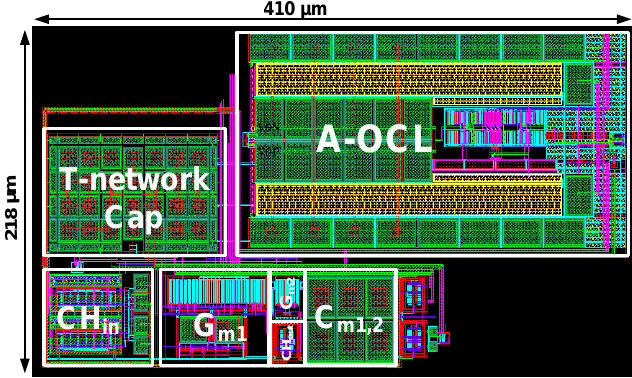
Figure 8. Chip layout of the proposed CCIA.